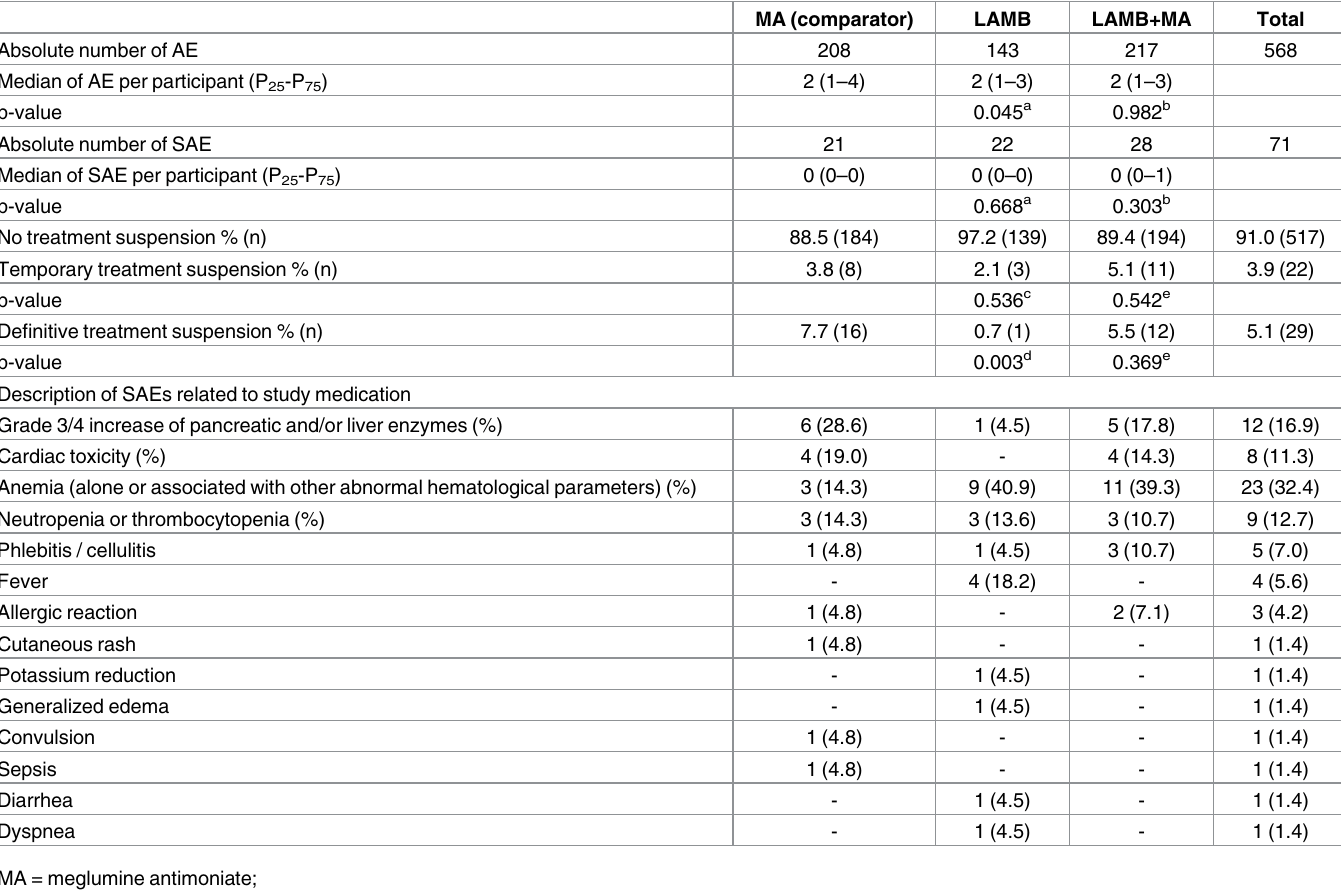
Table 6. Frequency of AE and SAE related to study medication, and temporary and definitive treatment suspension due to the occurrence of AE per intervention